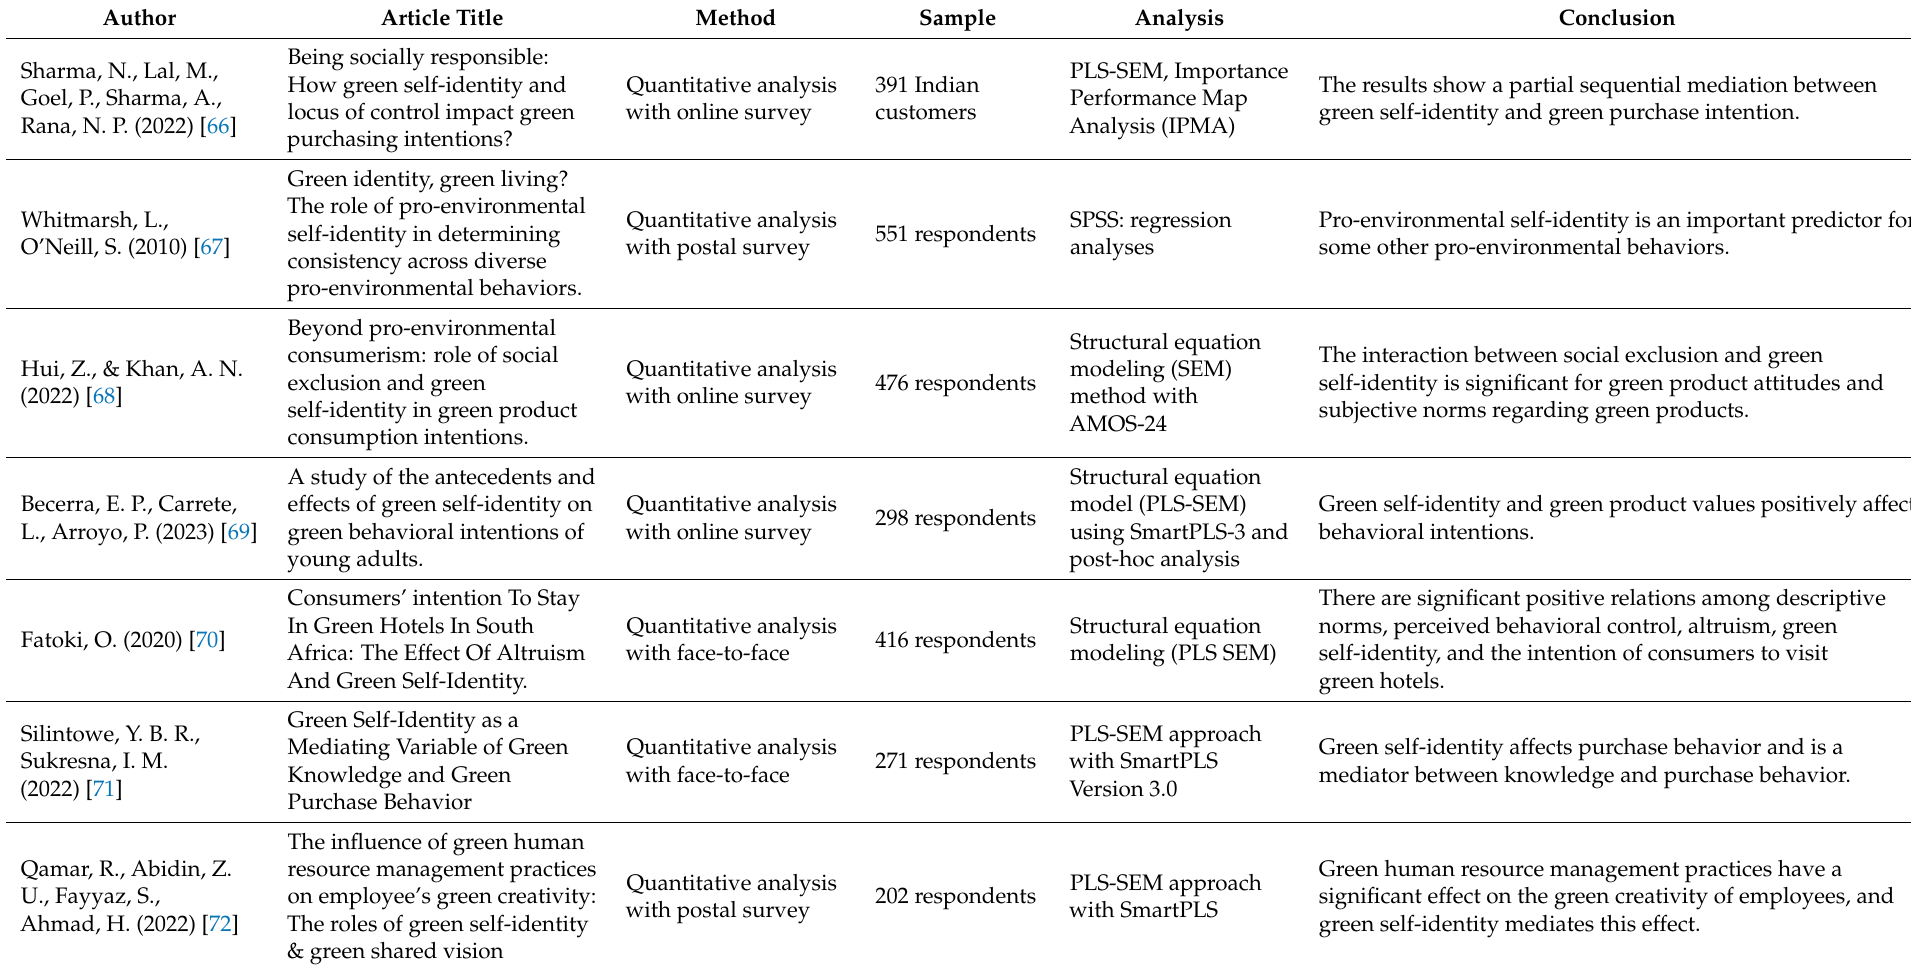
Table 3. Summary and comparison of related studies in the field of green